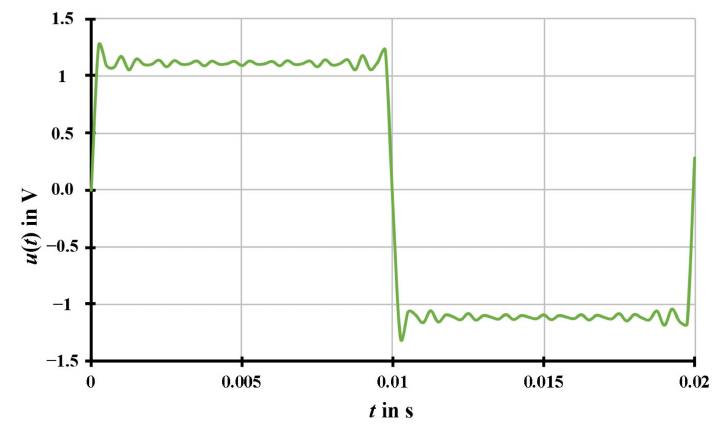
Figure 9. The generated square waveform at 50.1 Hz based on the harmonic series. The signals are simulated with parameters of f S = 4000 Hz, T W = 1 s, U 1 = 1 V, f 1 = 50.1 Hz, ϕ 1 = 0 ◦ , U H = 1 / (2 h + 1) · U 1 , f H = (2 h + 1) · f 1 , and ϕ H = 0 ◦ , where h is an integer and h = 0, 1, 2, ... , 15, without noise signal. The corresponding resampling amplitude and phase error of the square waveform signal are displayed in Figure 10.